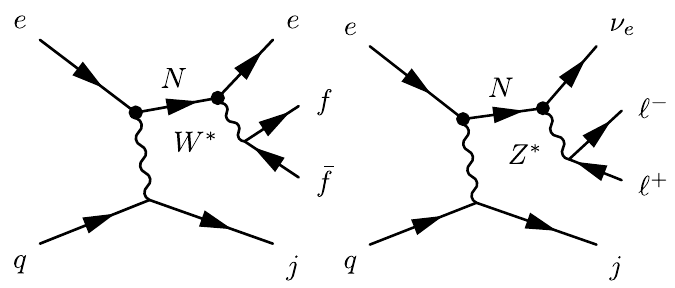
Figure 2 . Feynman diagrams for N production and decays via charged (left) and neutral (middle) currents and a three-body far-off shell.